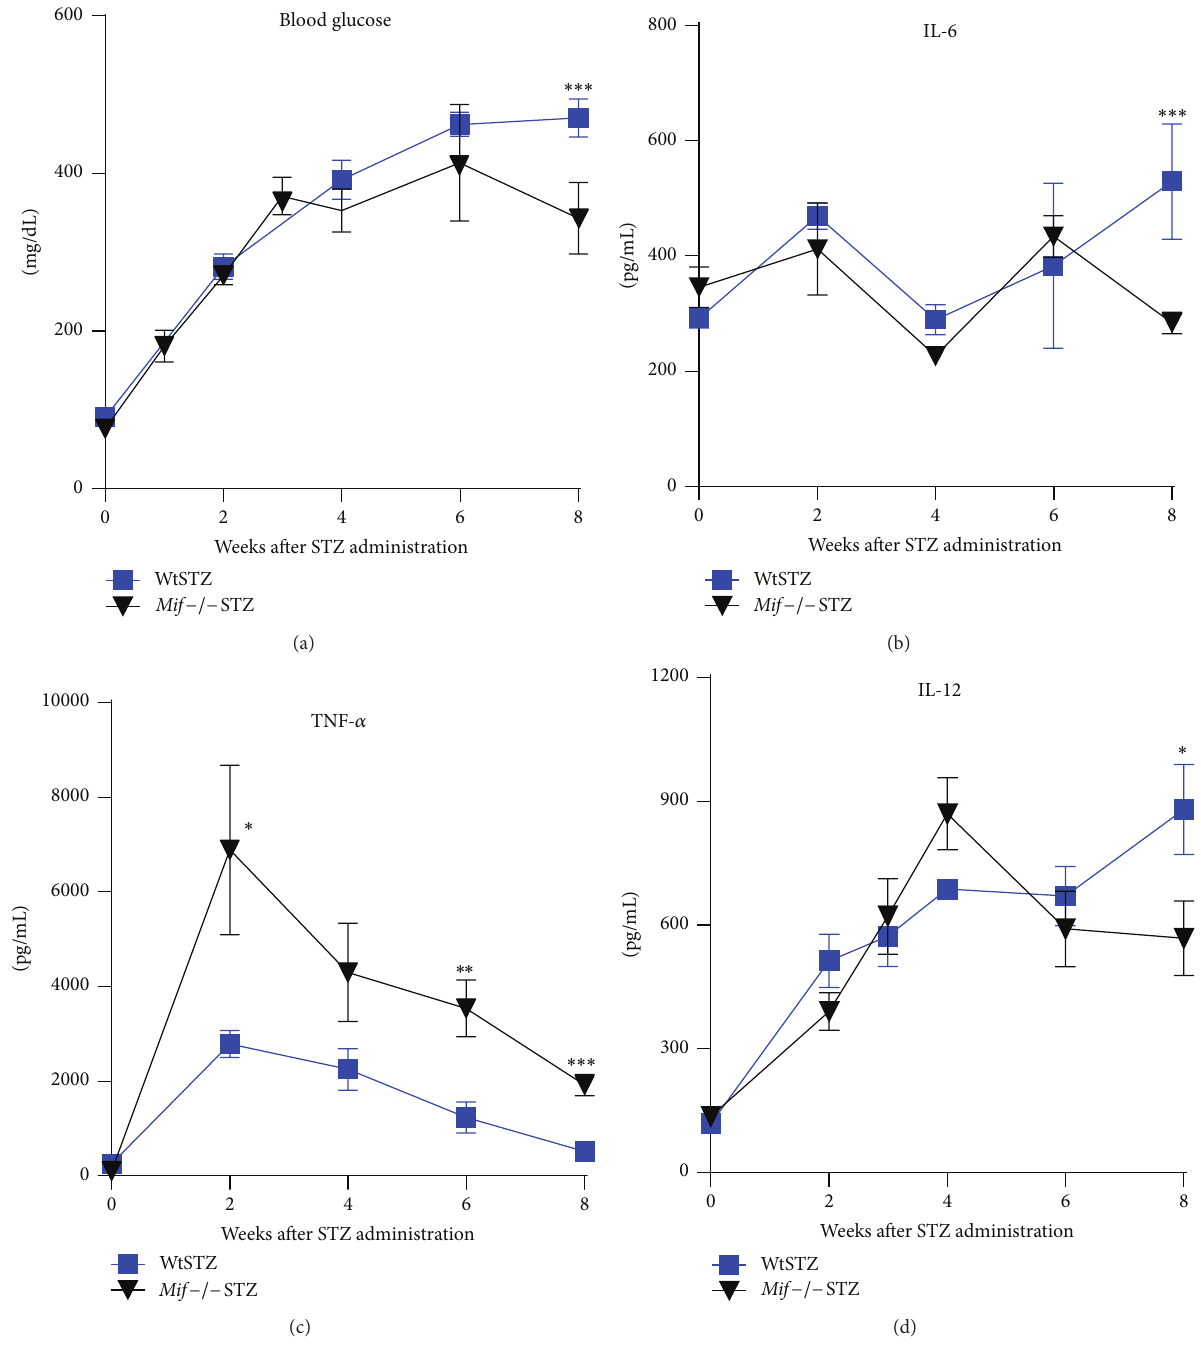
Figure 10: After Mif reconstitution, proinflammatory cytokine production in Mif − / − mice was increased.Mif reconstitution was initiated at the same time of STZ administration to Wt ( ◼ ) or Mif − / − mice ( 󳶃 ) until 7 weeks after STZ treatment. The glucose levels (a) and the levels of the inflammatory cytokines IL-6 (b), TNF-a (c), and IL-12 (d) were measured. Control mice receiving vehicle injection did not display significant changes on cytokine production compared to week 0 (data do not shown). The values are expressed as the means ± SEM of three independent experiments ( 𝑛 = 8 ). ∗ 𝑝 < 0.05 , ∗∗ 𝑝 < 0.01 , or ∗∗∗ 𝑝 < 0.001 , GraphPad Prism